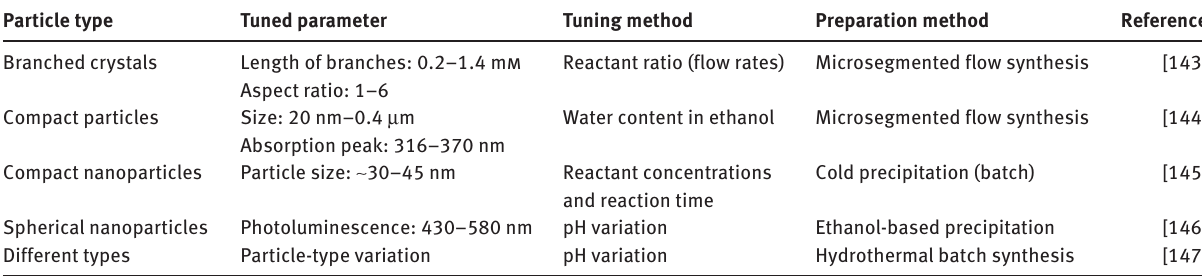
Table 3 Parameter tuning of ZnO microparticles and nanoparticles.